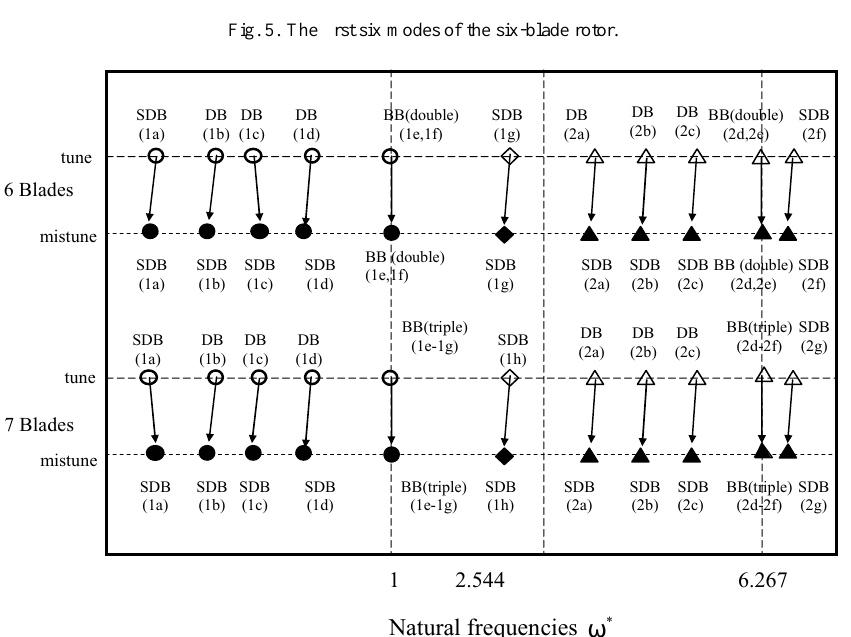
• Blades’ first mode predominates, (cid:5) (cid:1) Blades’